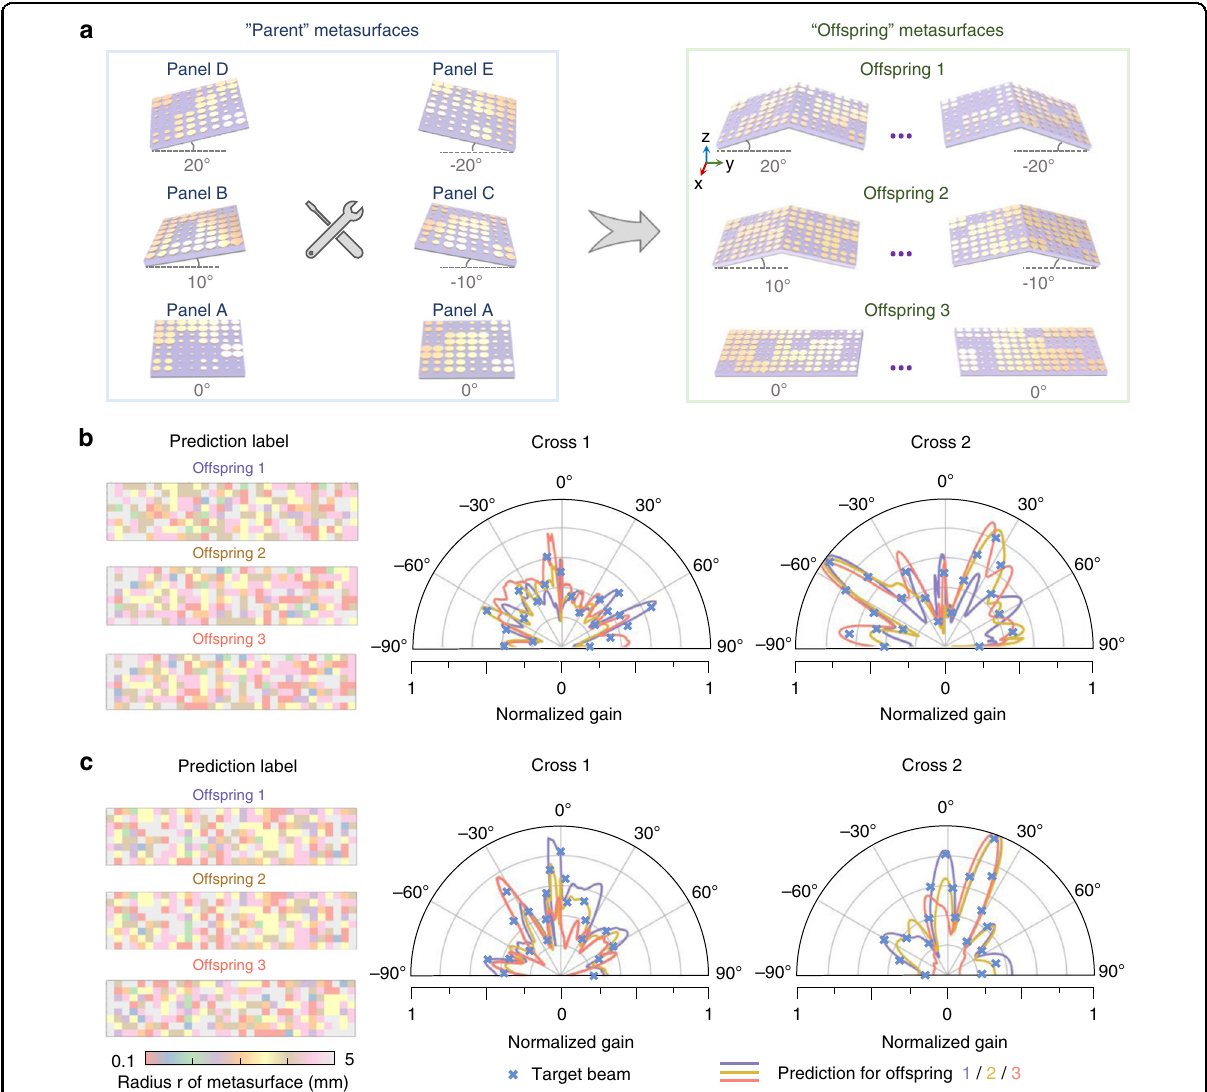
Fig. 4 Demonstration of the knowledge-inherited paradigm for periodic origami metasurfaces. a Assembly process of periodic origami metasurfaces. Three “ offspring ” metasurfaces with separate stretchable angles (± 20°, ± 10°, and 0°) are organized by Panel D/E, Panel B/C, and Panel A, abbreviated as offspring 1/2/3. Each “ offspring ” metasurface contains 16 panels (including 16 × 64 unit cells), with 8 extending along the y -axis and 2 extending along the x- axis. b , c Prediction labels and RCS results of three “ offspring ” metasurfaces. Given the same speci fi ed far- fi eld input (the blue cross), our knowledge-inherited paradigm for offspring 1/2/3 is capable of yielding similar on-demand scattering characteristics. The prediction labels, i.e., the prediction arrangement of metasurfaces, are presented on the